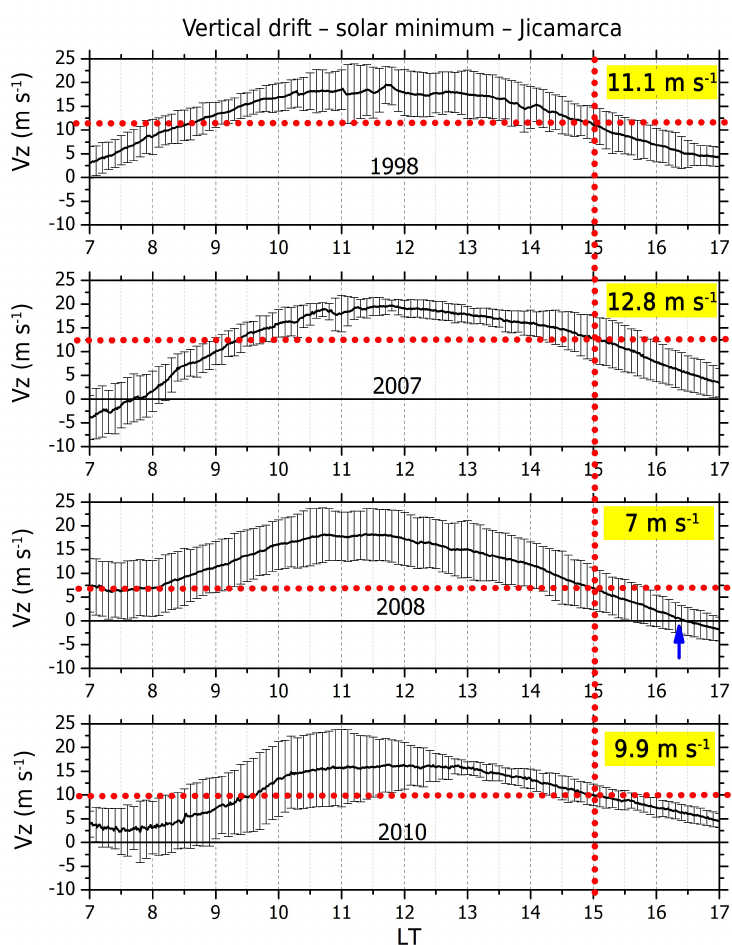
Figure 4. The vertical plasma drifts from magnetometers (Jicamarca–Piura: Jic-Piu) for different periods of solar minimum activity. The horizontal dotted line highlights the intensity of V z at 15:00LT. The blue arrow indicates that only in 2008 V z attained negative values before